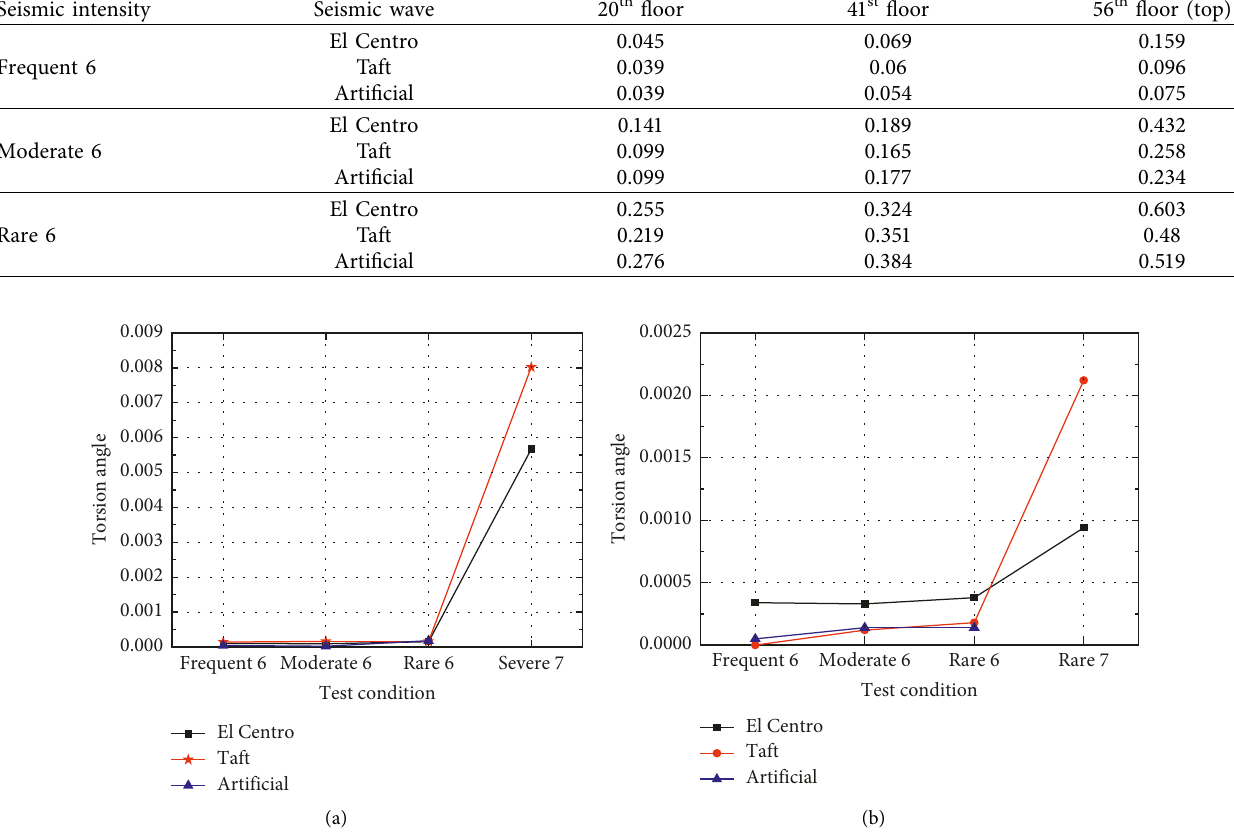
Figure 8: Torsion angle under different floors: (a) 41 st floor; (b) 51 st floor.